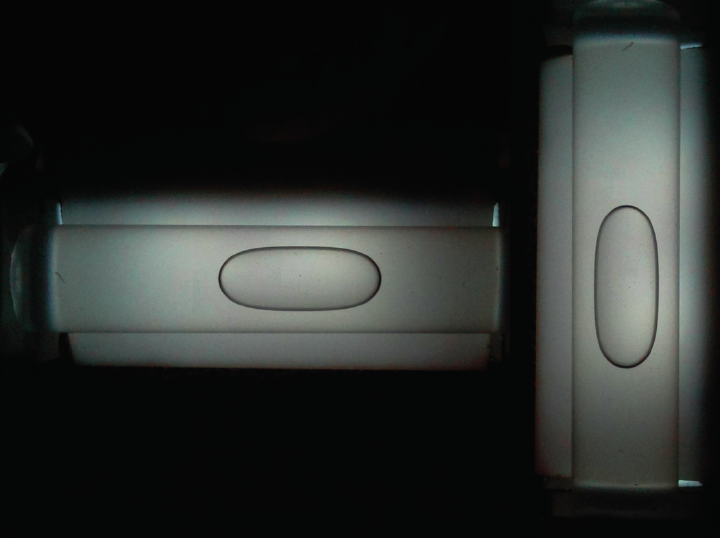
Figure 7. The full frame obtained by the Pi camera.